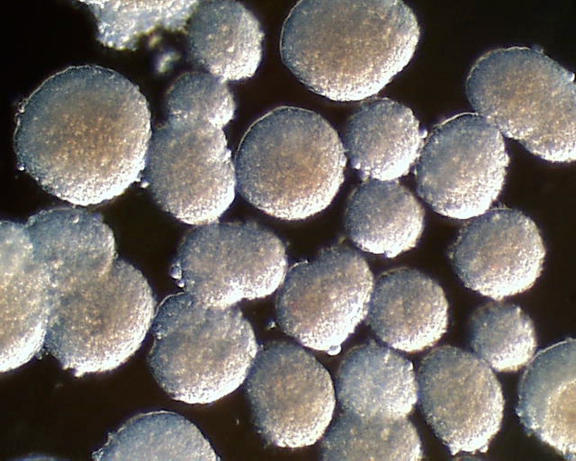
TGF-ß signaling is essential for maintaining the identity and function of pancreatic islet ß-cells. (Image: Hainan Chen and Seung Kim)